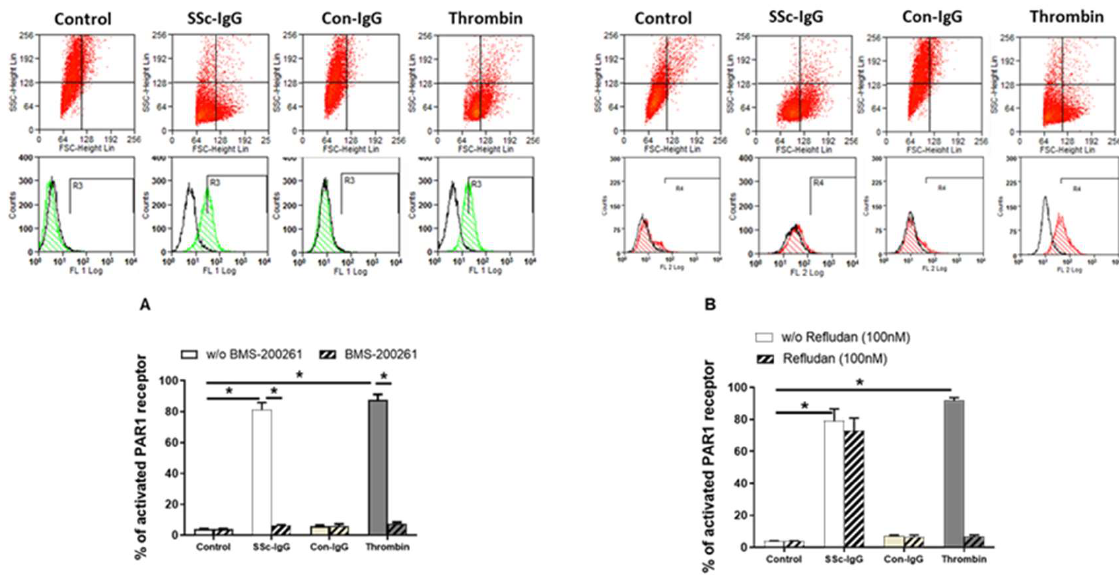
Figure 3. Effect of SSc-IgG on PAR-1 activation. HMECs were stimulated with SSc-IgG, Con-IgG or thrombin (0.1 U/mL) for 60 min and PAR-1 activation was then assessed by measuring the percentage of cleaved PAR-1 on the cell surface. HMECs were pretreated with either ( A ) BMS-200261 (PAR-1 inhibitor) or ( B ) refludan (thrombin inhibitor) for 24 h prior to stumulation. Representative histograms are from flow cytometry (FACS) with HMECs labelled with or without SPAN12 antibody, as described in Methods. The data on bar graphs are means ± SEM from 4 experiments with * p < 0.05.